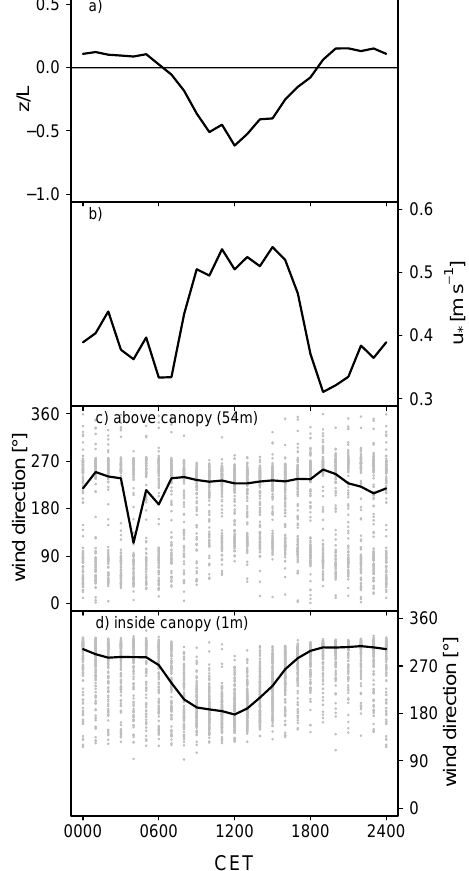
Fig. 4. Median diurnal cycles of (a) stability parameter z / L , (b) friction velocity u ∗ at EC height (54m) during May to August 2007. Half-hourly values (grey points) and median hourly values (solid line) of wind direction at (c) EC height (54m) and (d) inside the canopy